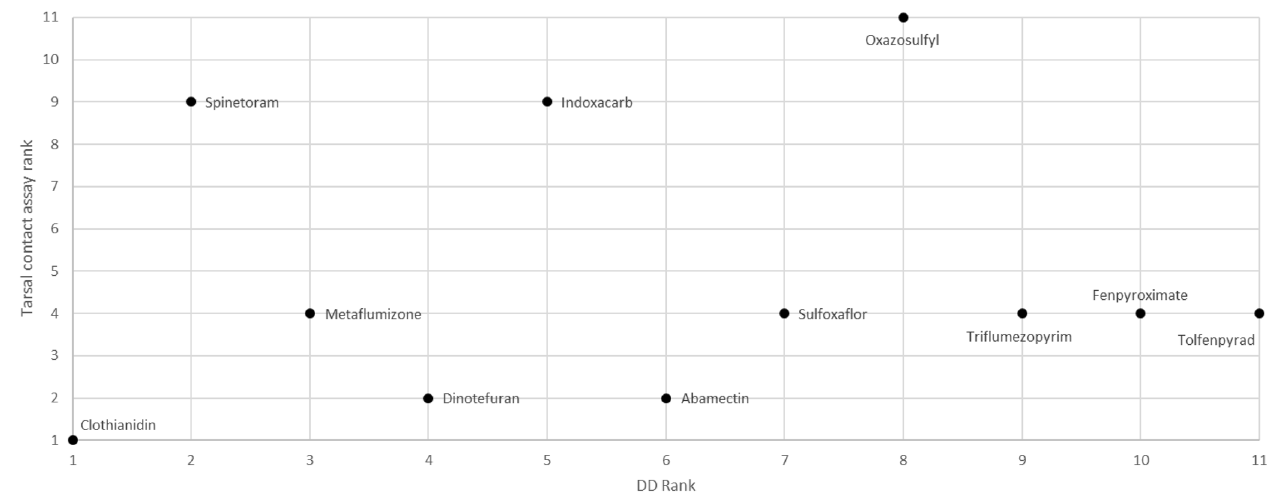
Figure 4. Relative potency of compounds assessed by discriminating dose and tarsal contact assay with RME. Compounds in the shortlist ranked from highest (1) to lowest (11) potency according to the breakpoint concentration in the tarsal contact assay with RME is plotted against the rank assigned according to the DD. Where compounds have the same breakpoint they were assigned the same rank and ranks skipped